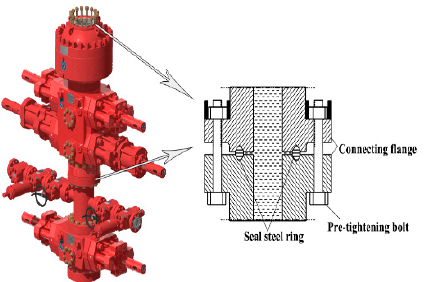
Figure 1. Schematic diagram of the sealing connection structure of a BOP stack.